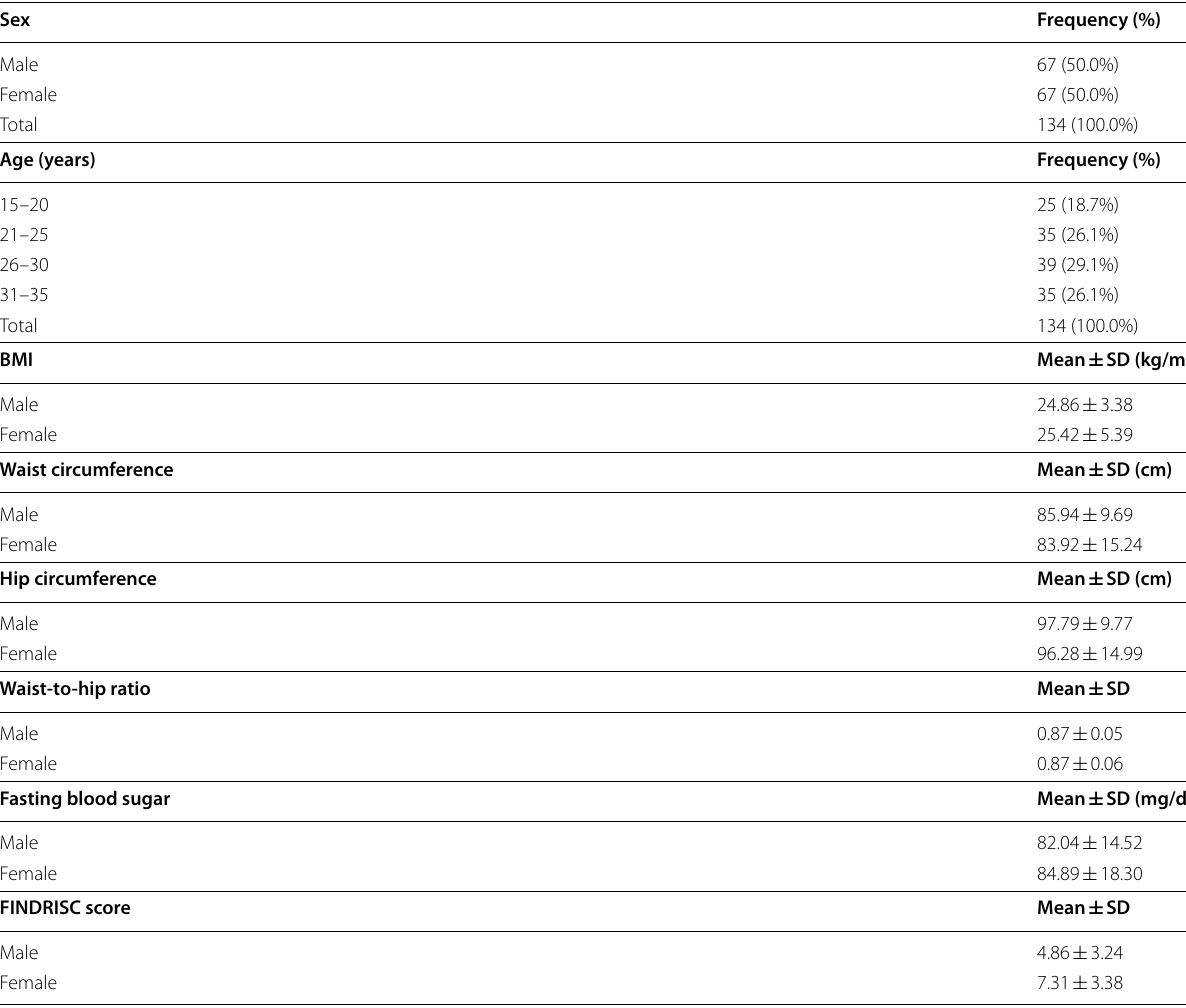
Table 1 Socio-demographic characteristics and mean data of